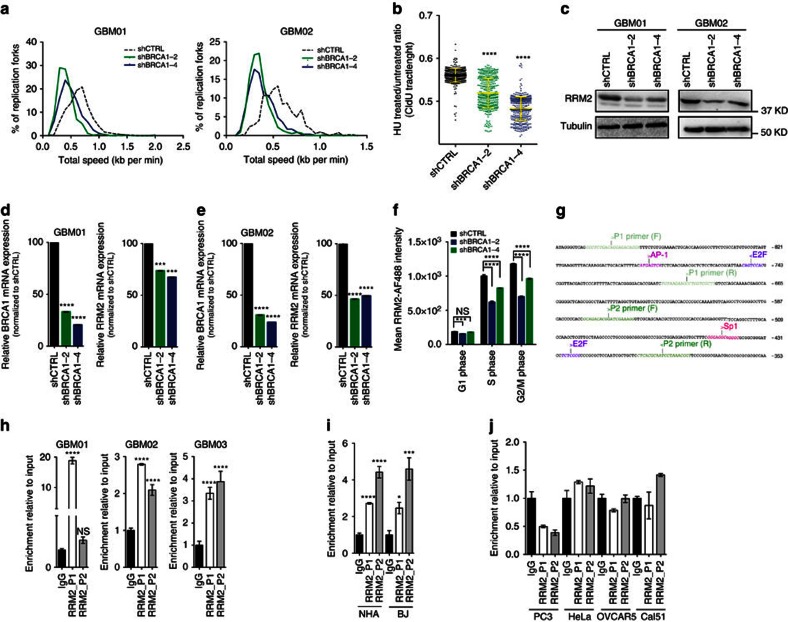
BRCA1 loss impedes replication fork progression by down-regulating RRM2 in GBM cells.(a) DNA fibre assay measuring the replication fork progression speed in GBM cells (GBM01 and GBM02) transduced with shCTRL or two independent BRCA1-targeting shRNAs (shBRCA1-2 and shBRCA1-4). See also Table 1. (b) Replication fork recovery assay showing the quantification of CldU tract length in GBM01 cells transduced with shCTRL or 2 non-overlapping BRCA1-targeting shRNAs (shBRCA1-2 and shBRCA1-4) and treated or not with 2 mM HU (4 h) prior CldU labelling. See also Table 2; Supplementary Table 1. (c) Immunoblot analysis of RRM2 protein levels in GBM cells transduced with shCTRL or two independent BRCA1-targeting shRNAs (shBRCA1-2 and shBRCA1-4). (d,e) RT-qPCR analysis of BRCA1 and RRM2 mRNA levels in GBM cells transduced with shCTRL or two independent BRCA1-targeting shRNAs (shBRCA1-2 and shBRCA1-4). (f) FACS analysis of RRM2 protein level changes throughout cell cycle in GBM cells (GBM01) transduced with shCTRL or two independent BRCA1-targeting shRNAs (shBRCA1-2 and shBRCA1-4). (g) Partial sequence of the human RRM2 promoter (GenBank accession number AY032750)33, which was used to design Chip primers: P1 primer forward (F)/reverse (R) and P2 primer forward (F)/reverse (R). Positions are numbered from the downstream transcription initiation site (+1). Putative binding sites for transcription factors are color-coded and identified above the sequence. (h) Chip immunoprecipitation of BRCA1 binding RRM2 promoter in GBM01-03 cells using primer set P1 and P2. (i) Chip immunoprecipitation of BRCA1 binding RRM2 promoter in NHA-DRB and BJ cells using primer set P1 and P2. (j) Chip immunoprecipitation of BRCA1 binding RRM2 promoter in PC3, HELA, OVCAR and Cal51 cells using primer set P1 and P2. Statistical significance was calculated by one-way ANOVA and Tukey’s multiple comparisons test in d–f,h–j or Student’s t test (a,b) and all data are shown as means±s.d. and performed as technical triplicates. (*P<0.05, **P<0.005, ***P<0.005, ****P<0.0001; NS represents non-significance).